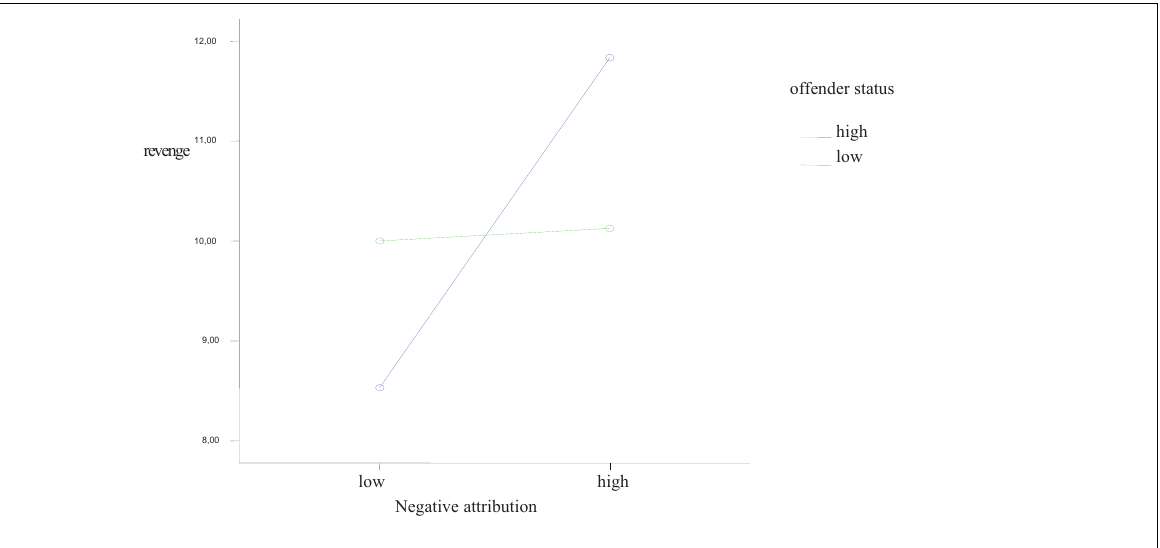
FIGURE 2 | The interaction between that offender’s status and the negative causal